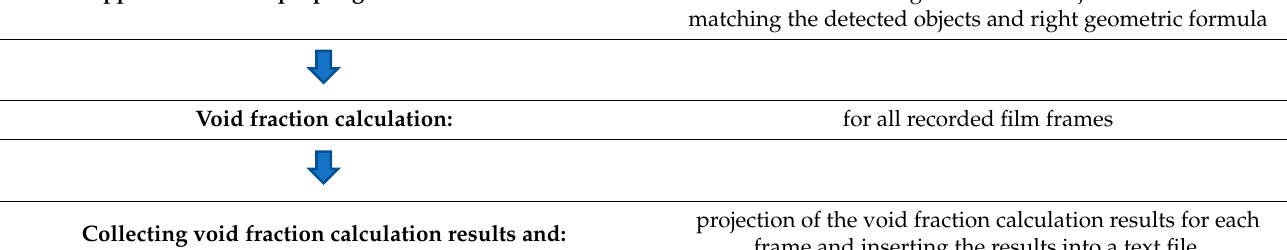
Table 1. Global scheme of the Matlab script functioning.